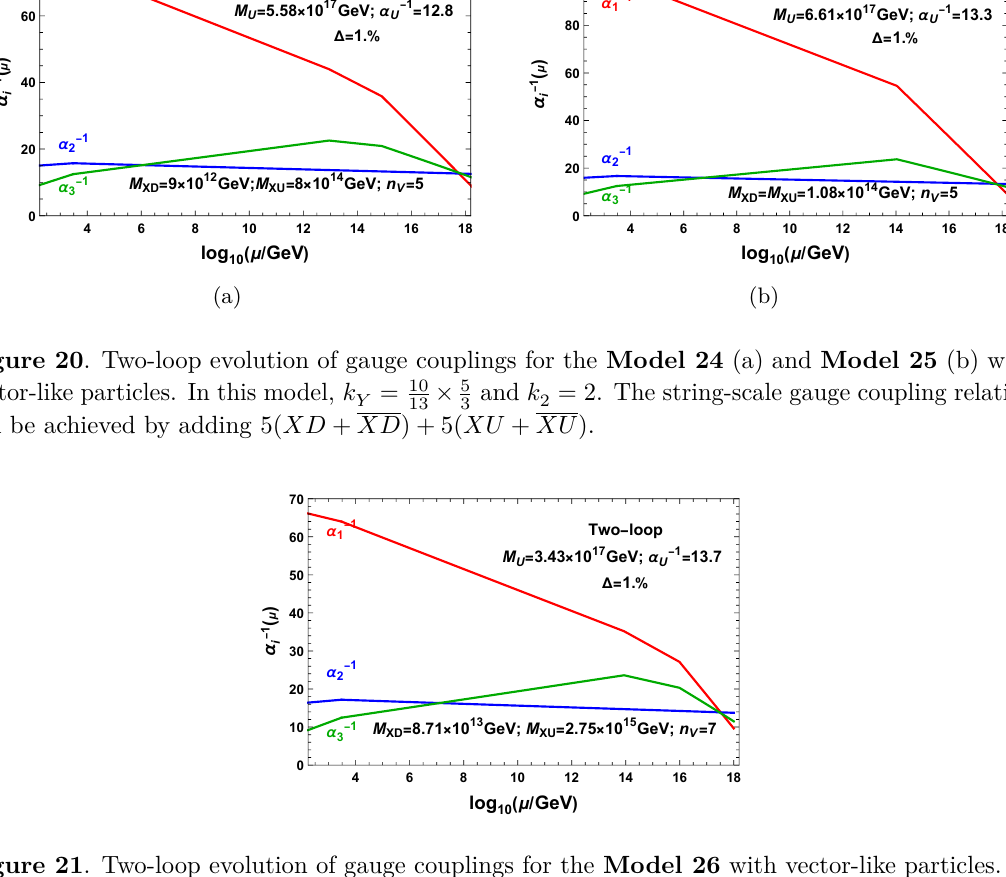
Figure 21 . Two-loop evolution of gauge couplings for the Model 26 with vector-like particles. In this model, k = 25 × 5 and k = 11 . The string-scale gauge coupling relation can be achieved by Y 2 28 3 6 adding 7( XD + XD ) + 7( XU + XU ) .